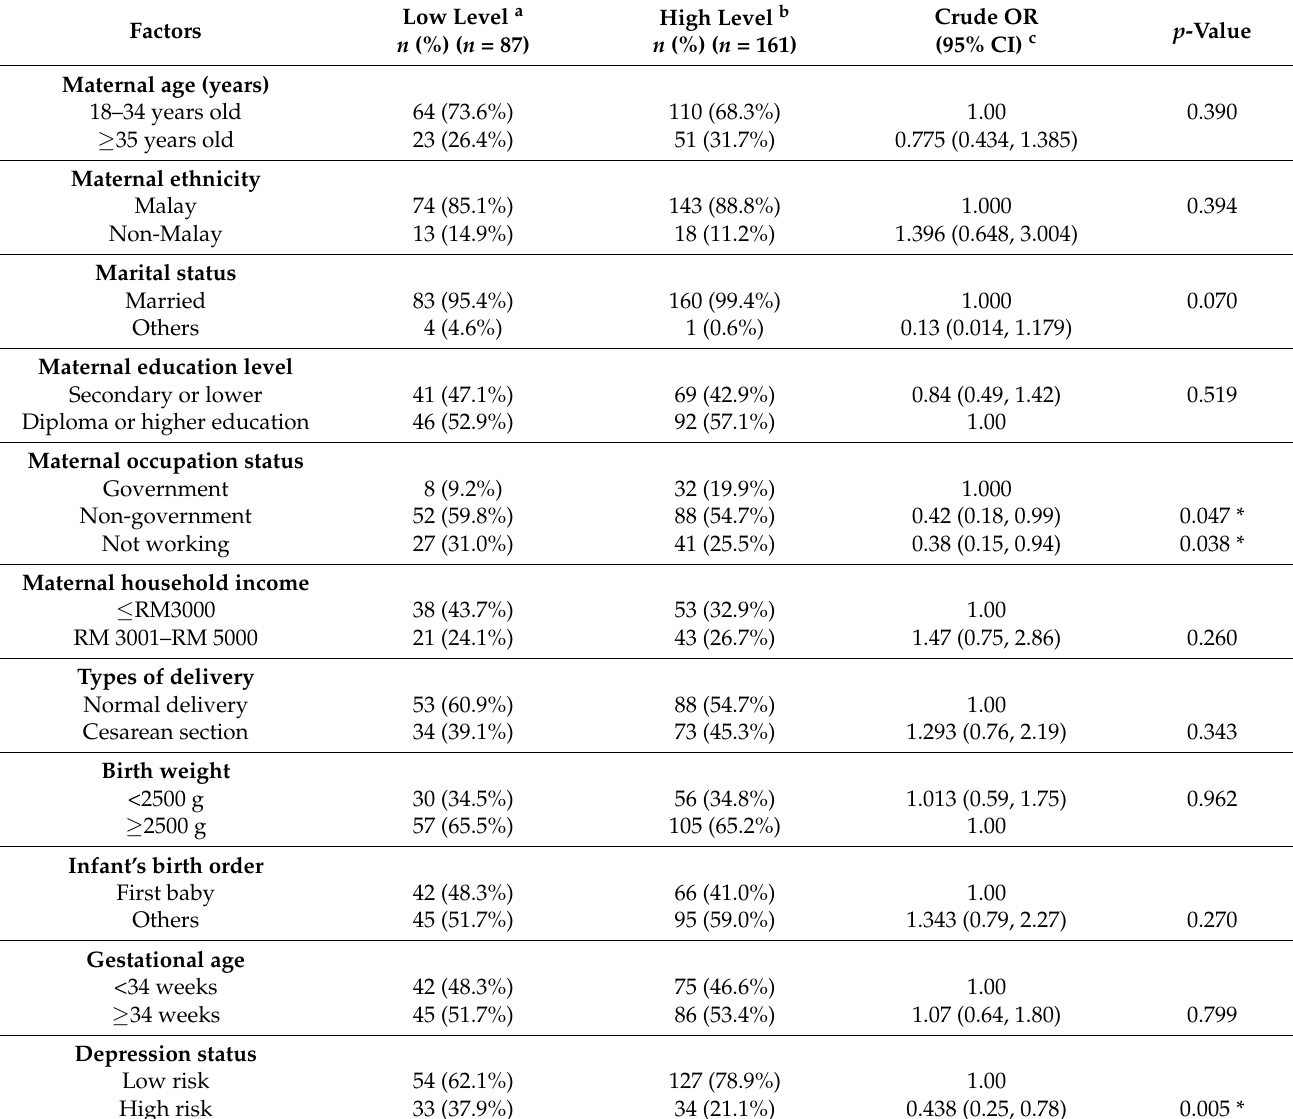
Table 3. Association between participant’s background and positive breastfeeding attitude ( n = 248). Factors